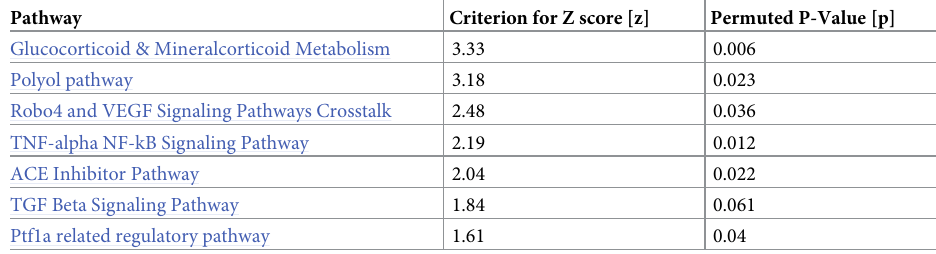
Table 4. Pathway statistics: G3_SGE+BEV_vs_SGE, fold change < 0.25. Pathway Criterion for Z score [z] Permuted P-Value [p] Glucocorticoid & Mineralcorticoid